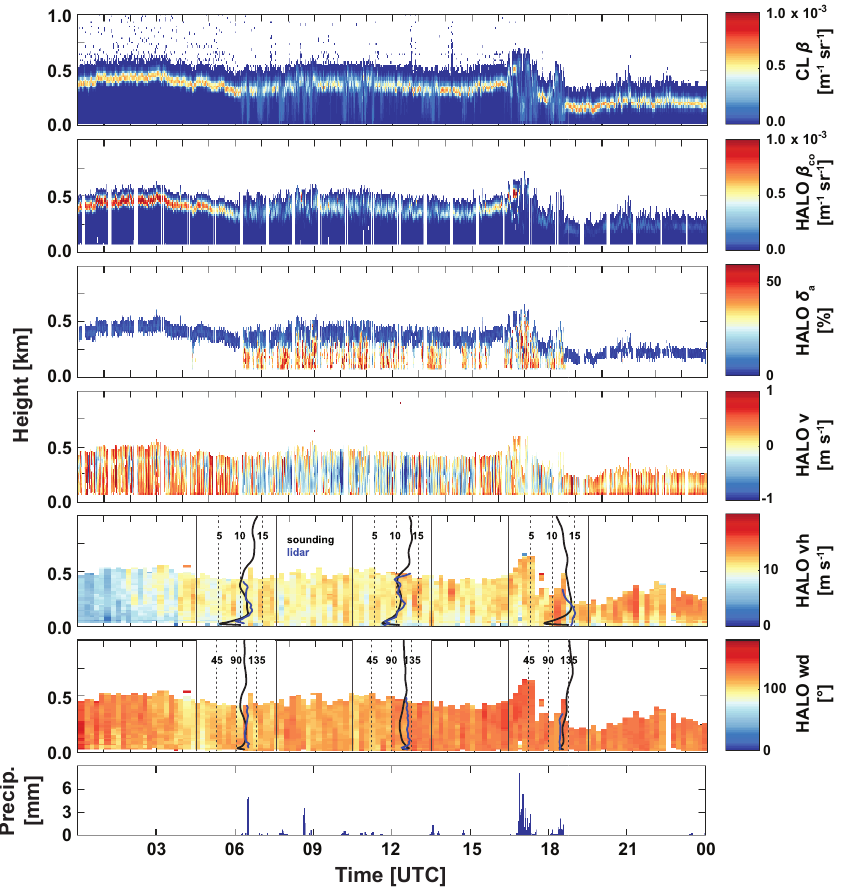
Figure 7. Example measurement of 17 September 2014: calibrated backscatter coefficients from ceilometer (a) and Doppler lidar (b) , depolarisation ratio (c) , vertical (d) and horizontal (e) wind speed, wind direction (f) from Doppler lidar, and precipitation amount from a precipitation sensor on the ship (g) . The profiles in (e) and (f) show the comparison of horizontal wind speed and direction to the radiosondes launched at 06:00, 12:00, and 18:00UTC. The ship’s average speed during that day was 0.5 and 4.5ms − 1 before and after 15:00UTC,